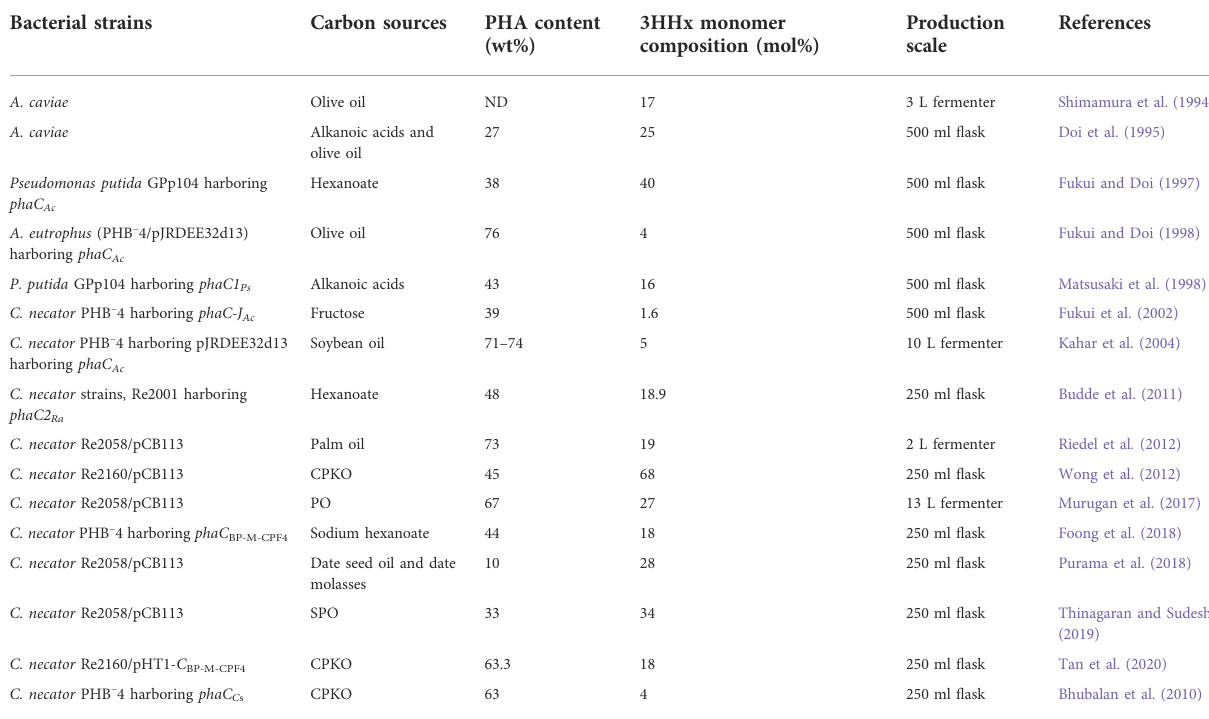
TABLE 2 Production titers of P(3HB- co -3HHx). Bacterial strains